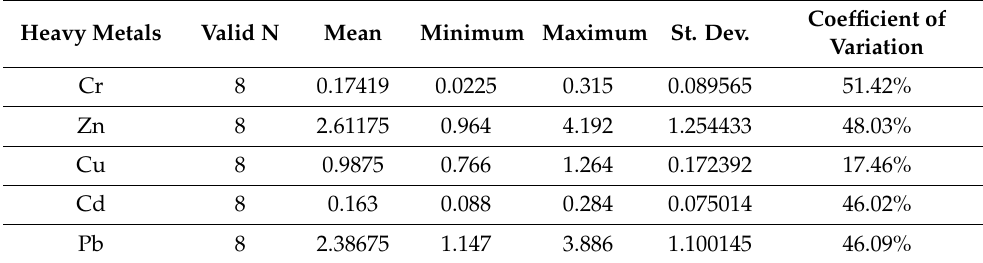
Table 2. The standard deviation of the content of heavy metals in samples of apples. Heavy Metals Valid N Mean Minimum Maximum St. Dev.